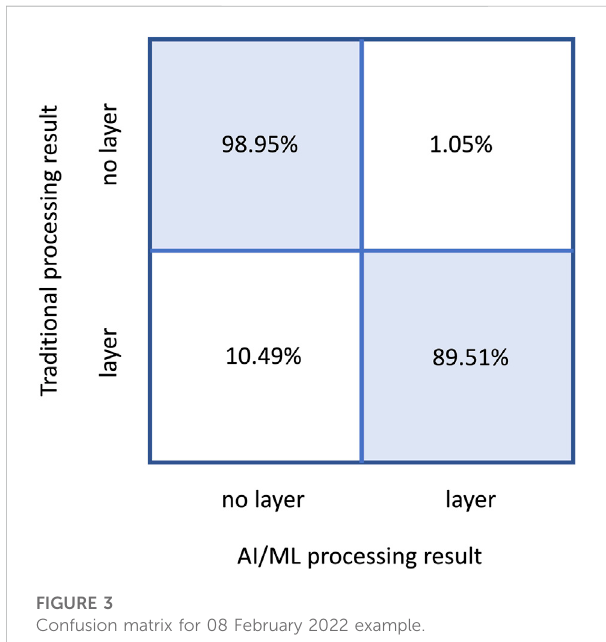
FIGURE 3 Confusion matrix for 08 February 2022 example.